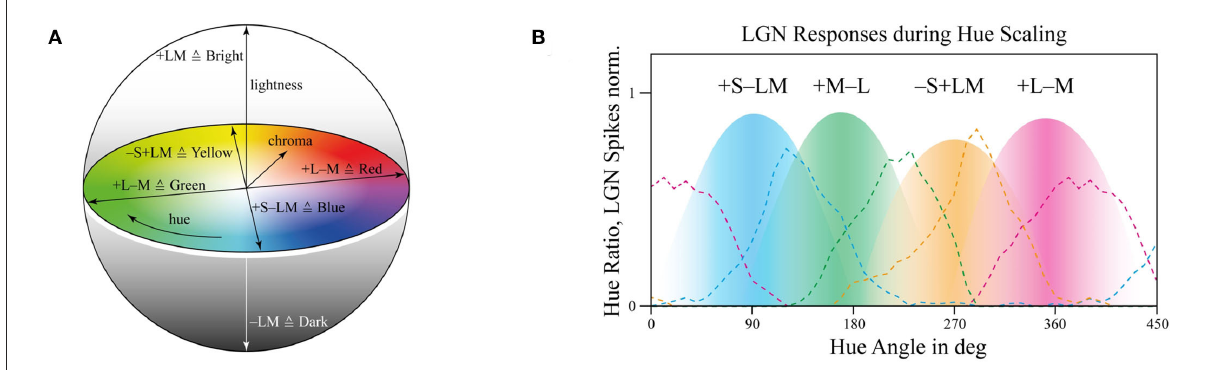
FIGURE1 (A) Three-dimensional color sphere based on the opponent color theory with lightness axis for ± LM, red–green as ± L ± M, and blue–yellow as ± S ± LM including chroma and hue. (B) Hue ratios, in dotted lines, and retinal cellular opponent responses as surfaces, data from De Valois